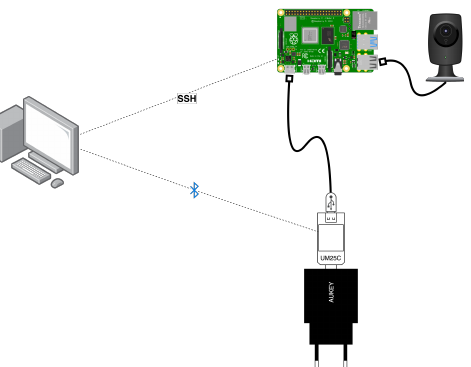
Figure 5. Overview of the measurement setup. The Bluetooth digital multimeter allows three measurements per